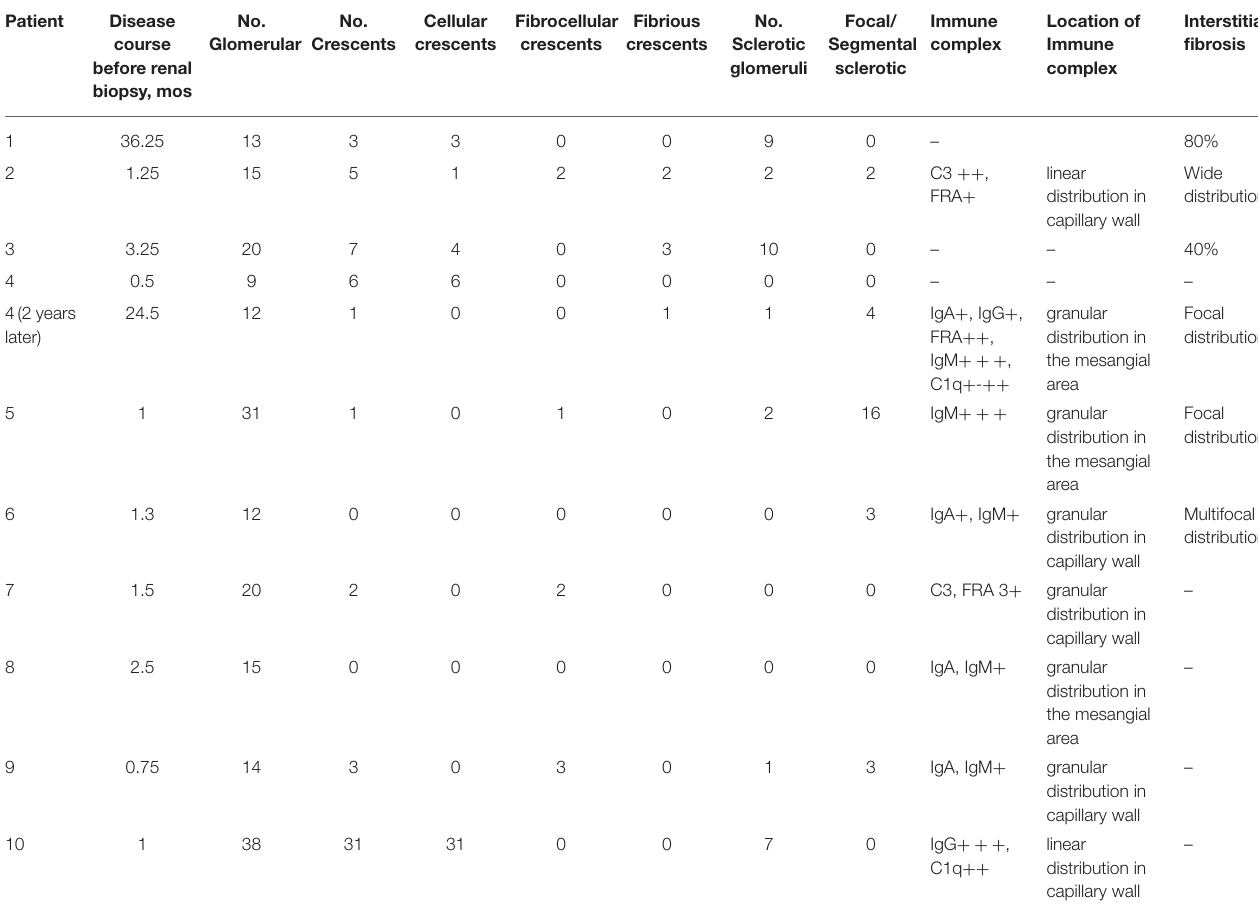
TABLE 2 | Summary of renal pathological features of 10 children with MPA. Patient Disease course before renal biopsy,